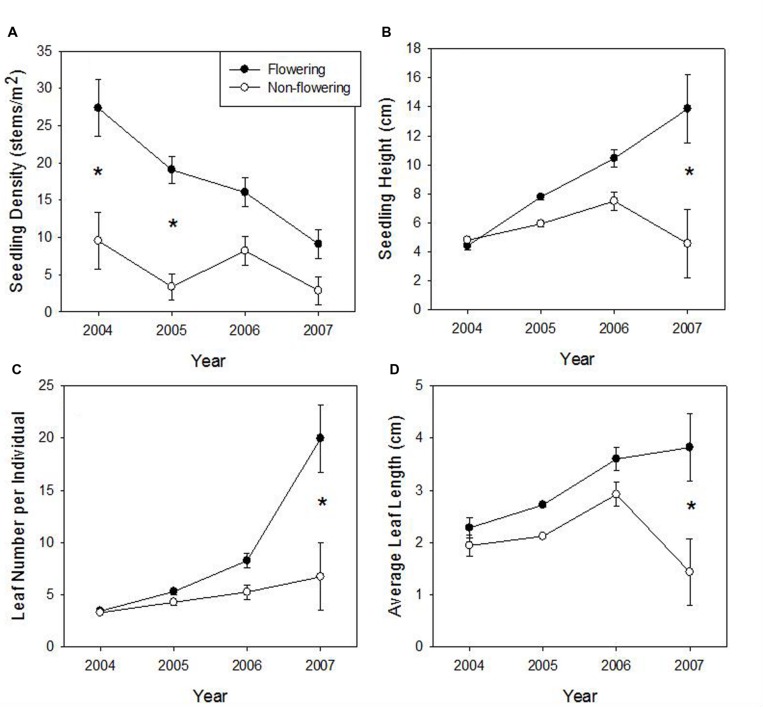
Means (±1 SE) of density of seedlings (A) seedling height (B), seedling leaf number (C), and average seedling leaf length (D) at the Taibaishan National Natural Reserve, Shaanxi Province, China. Asterisks indicate significant difference in flowering and un-flowered sites for a particular year at P < 0.05 level with Bonferonni correction.